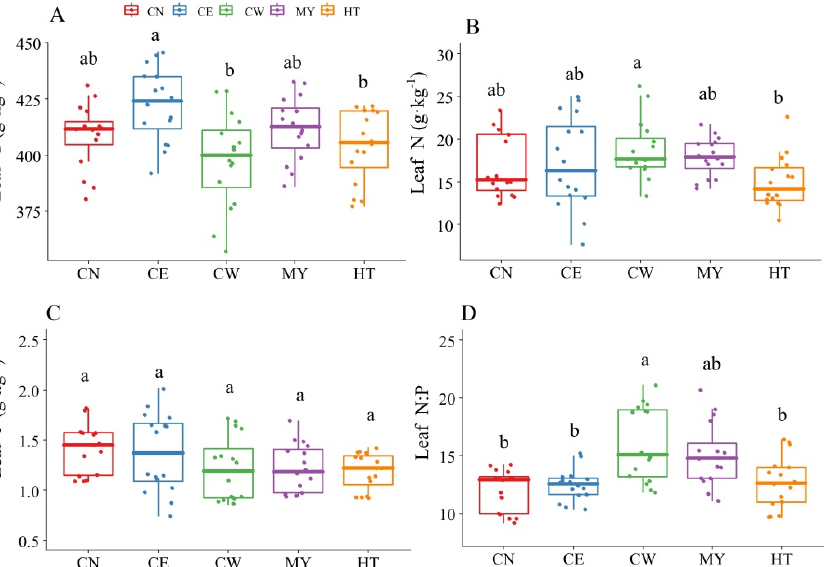
Figure 2. Changes in the leaf ecological stoichiometry of A. sparsifolia at the study sites. Vertical bars represent standard deviations, and the letters denote significant differences among different groundwater depths ( p < 0.05). CW, west of Cele county; MY, Moyu county; HT, Hetian county; CN, north of Cele county; CE, east of Cele county. ( A – D ) represent variations of leaf C, N, P, and N:P ratio at the study sites.